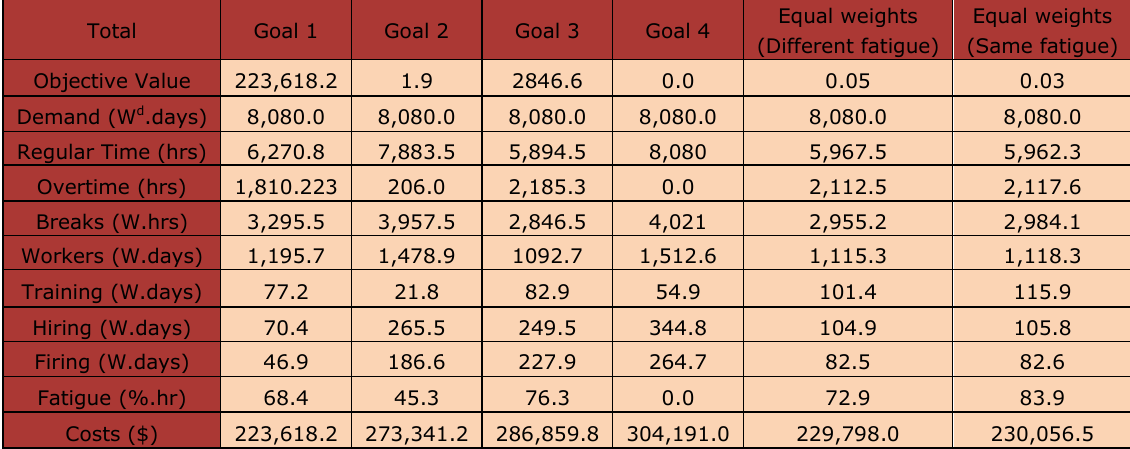
Table 10. Comparisons Between the Different